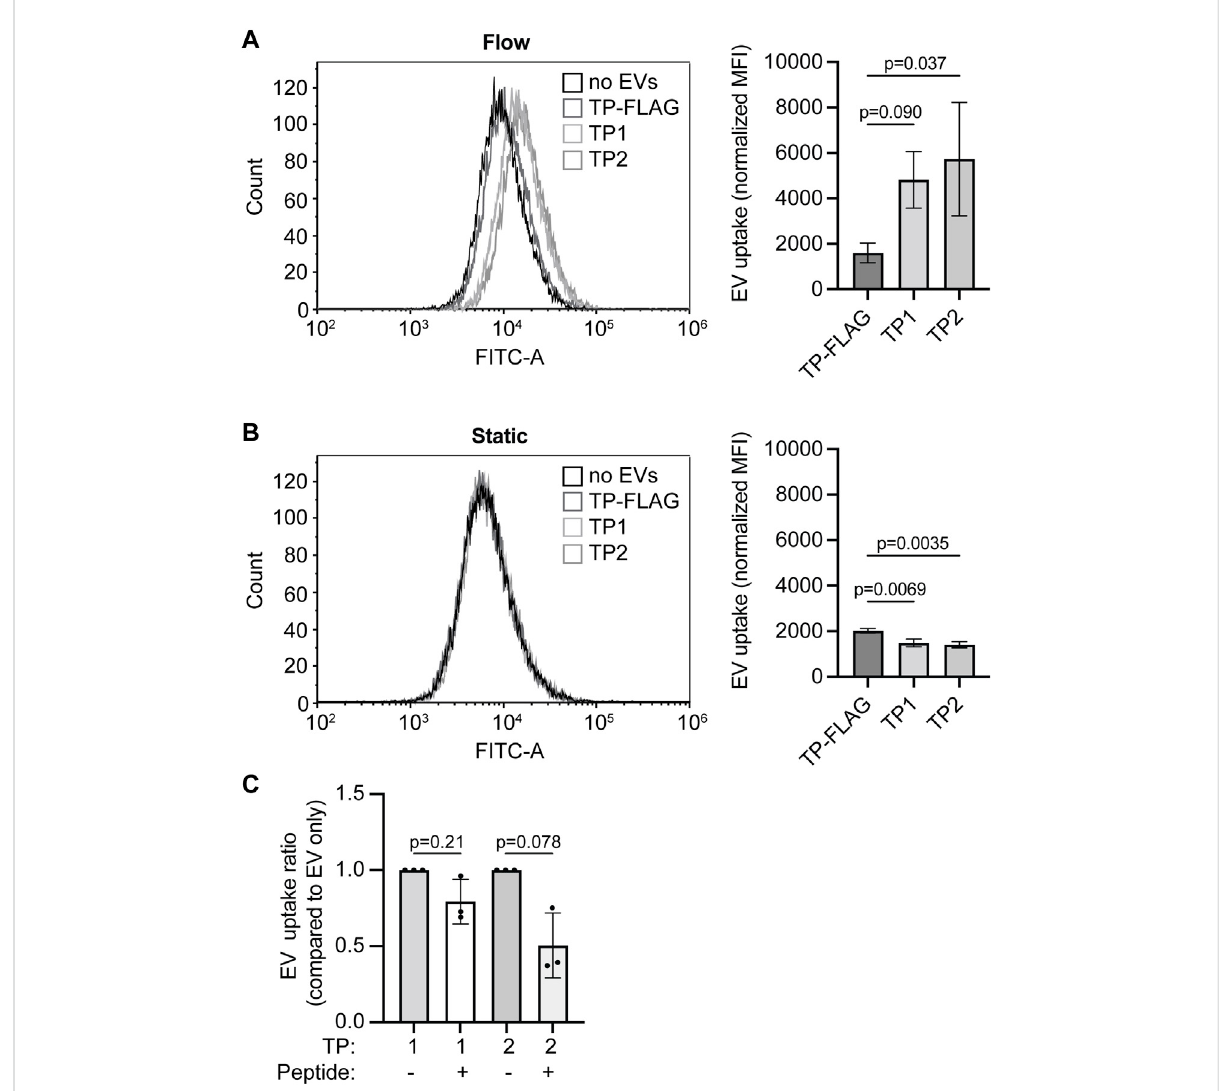
FIGURE 7 Targeting peptide expression on EVs increases EV uptake in HMEC-1 under fl ow conditions. (A, B) EV-TP1, -TP2, and -TP-FLAG uptake in HMEC-1 under (A) fl ow or (B) static conditions, determined by fl ow cytometry. Mean fl uorescence is corrected for negative control (M199 medium administration). (C) EV-TP1 and EV-TP2 uptake in HMEC-1 under fl ow after HMEC-1 pre-incubation of CRGDC or CRPPR peptides. For each replicate,mean fl uorescenceiscorrectedfortheaverageofnegativecontrol,andconditionswithpeptidesarecomparedtoconditionswithout peptide pre-incubation. Data are displayed as mean ± SD and represent three replicate